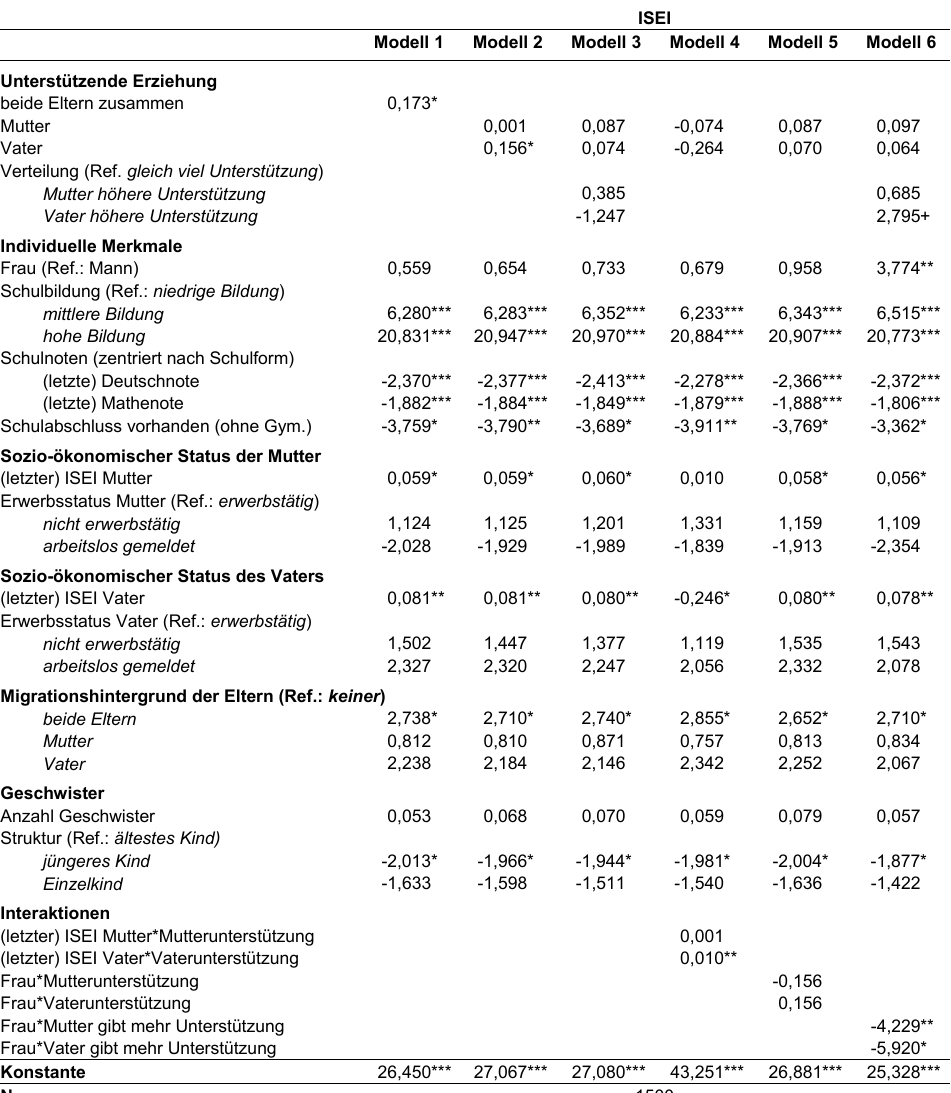
Tabelle 2 : Regressionsmodelle zu den Einflussfaktoren der beruflichen Aspirationen